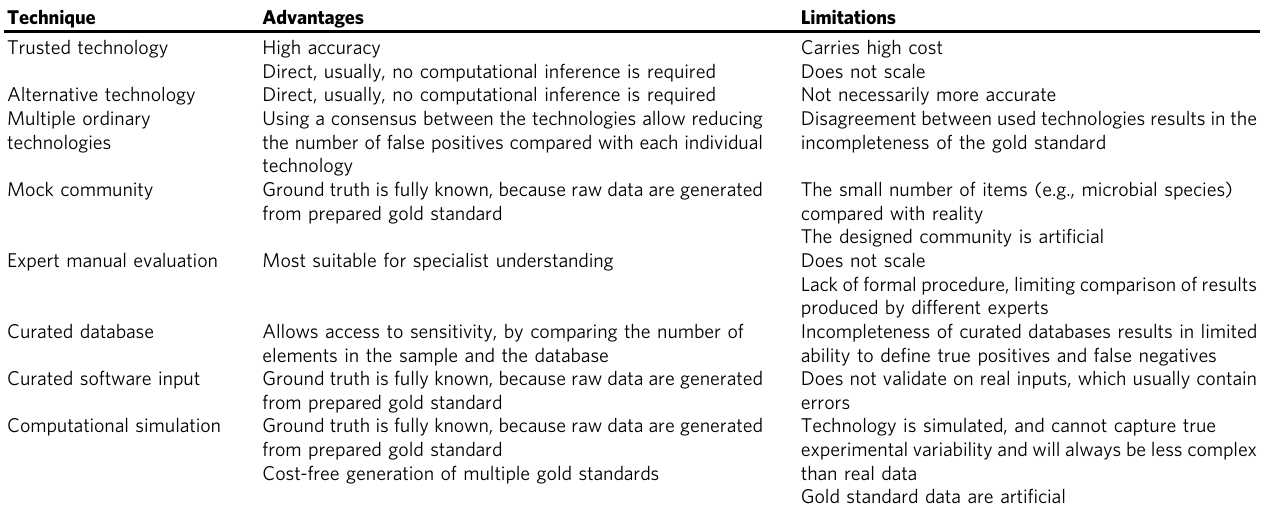
Table 1 Advantages and limitations of various techniques used to prepare gold standard